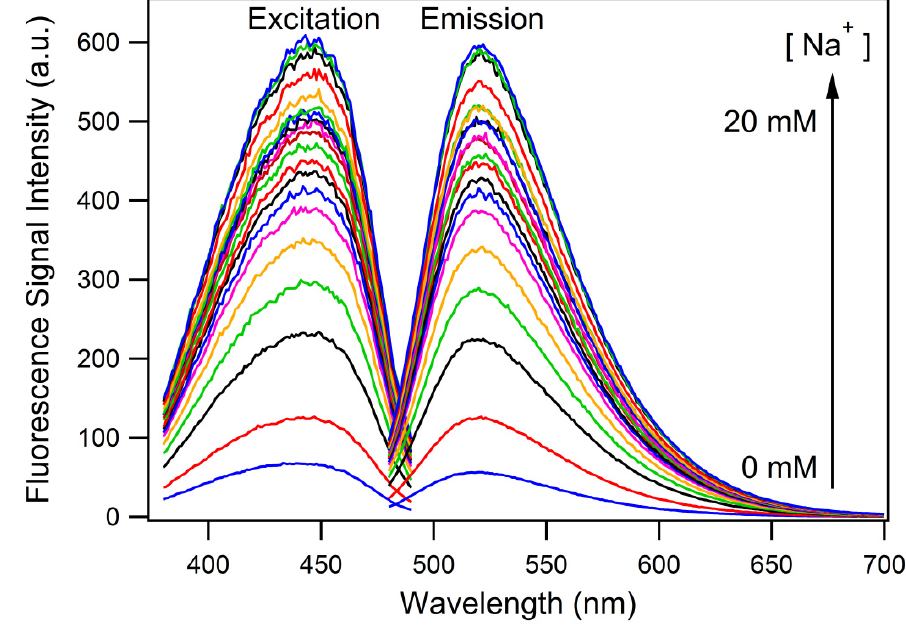
Figure 2. Excitation and emission spectra of the FI in acetonitrile ([NEt with sodium ion ( i.e. , sodium perchlorate) concentrations from 0–20 mM and constant FI concentration (0.02 mM). The excitation (left) and emission (right) spectra were recorded at fixed emission and excitation wavelengths of 520 nm and 440 nm, respectively.